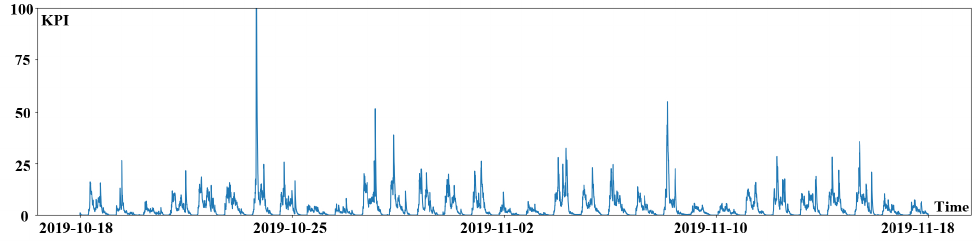
Figure 1. The sample KPI time series data after data pre-processing.